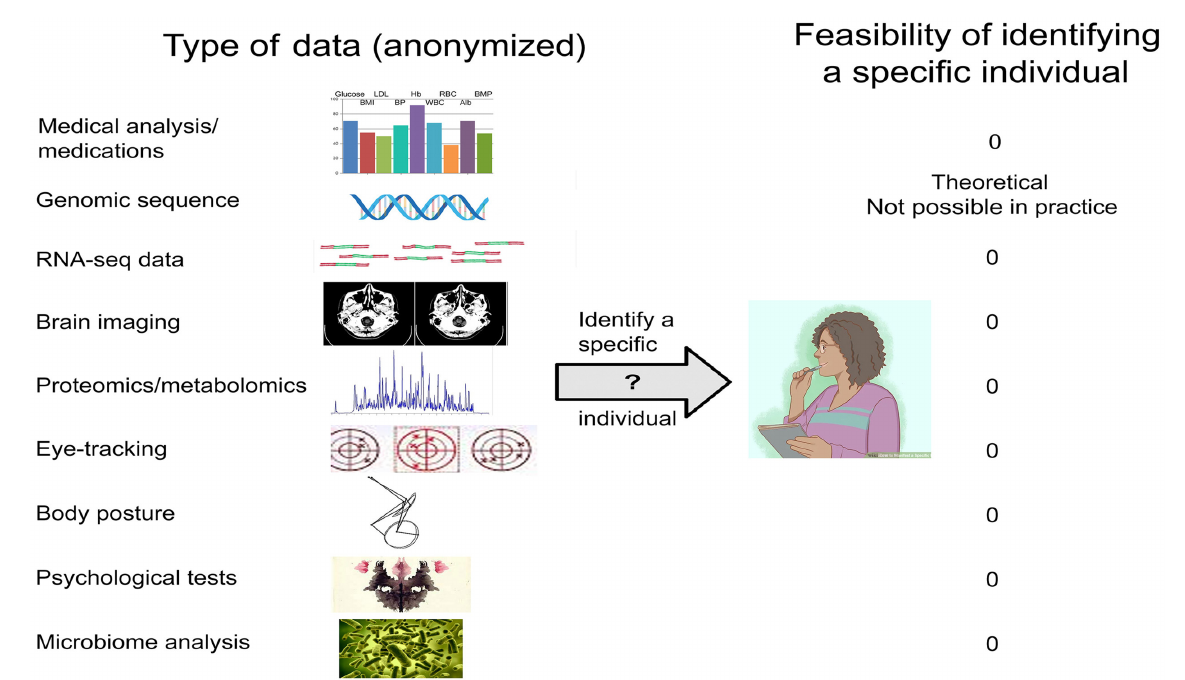
FIGURE2 Types of biomedical data relevant to the neurosciences, and the feasibility of identifying a specific